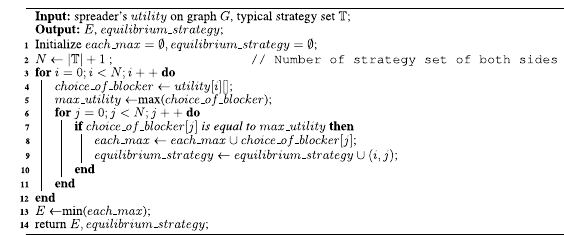
Algorithm 1. The algorithm of backward induction to fi nd the equilibrium